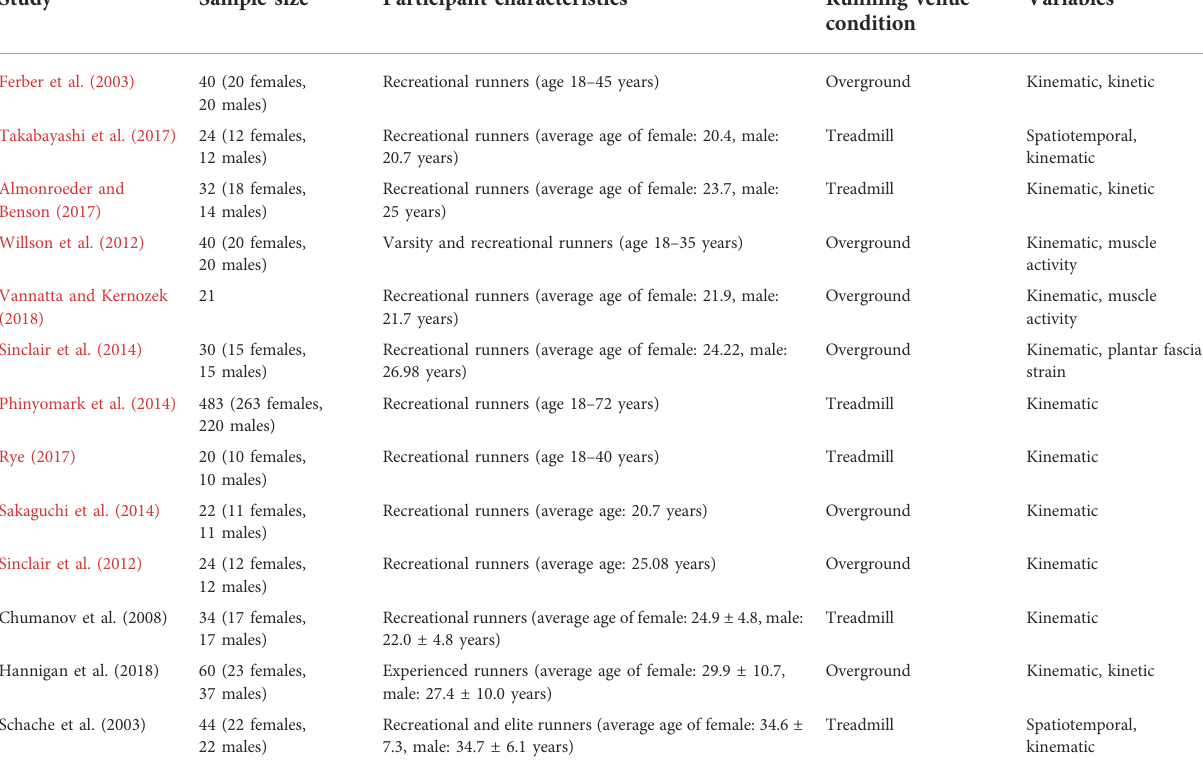
TABLE 2 Characteristics of selected